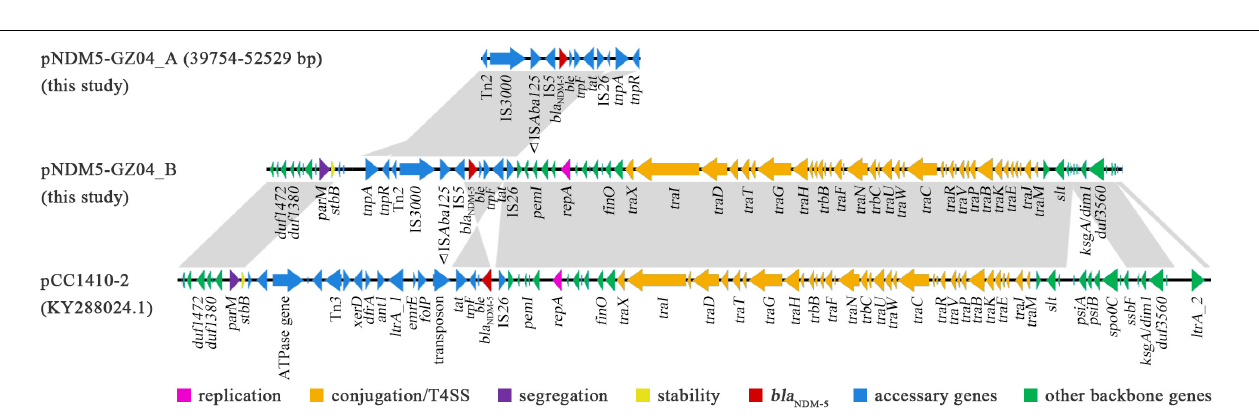
FIGURE 4 | The comparative structures of plasmids pNDM5-GZ04_B, pCC1410-2, and fragment of pNDM5-GZ04_A. The open reading frames are shown by arrows. Regions with > 99% identity among different plasmids are denoted by light gray.